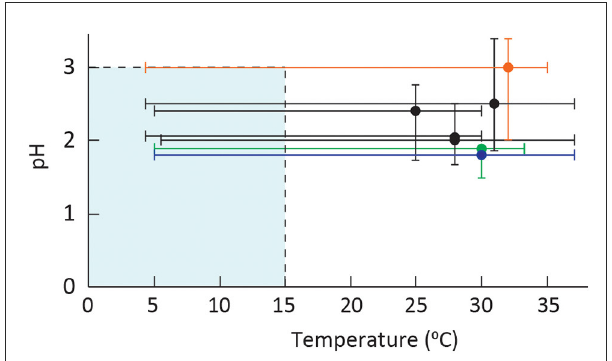
FIGURE3 Plot of pH vs. temperature optima and ranges of characterized eurypsychrophilic acidophiles with the limits of low-temperature growth and extreme acidophiles are shaded in blue. The species are A. ferrivorans strains (all in black) from top to bottom NO-37, CF27, SS3, and ACH; At. ferrooxidans PG05 and MC2.2 represented as a single line (blue); “ F. myxofaciens ” P3G (orange); and A. ferriphilus M20 (green). The strains with an optimum pH of 2.5 were slightly adjusted for visual clarity.